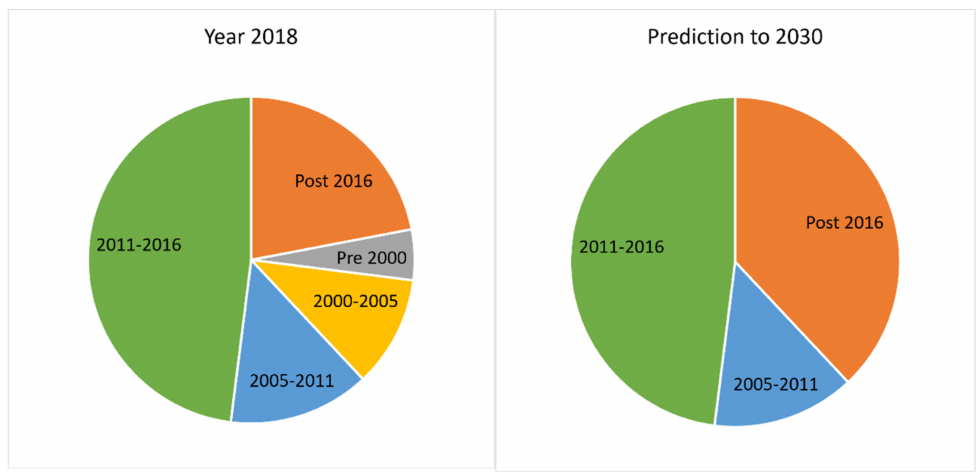
Figure 6. Distribution of ships, by year of manufacture, visiting the Haifa and Ashdod